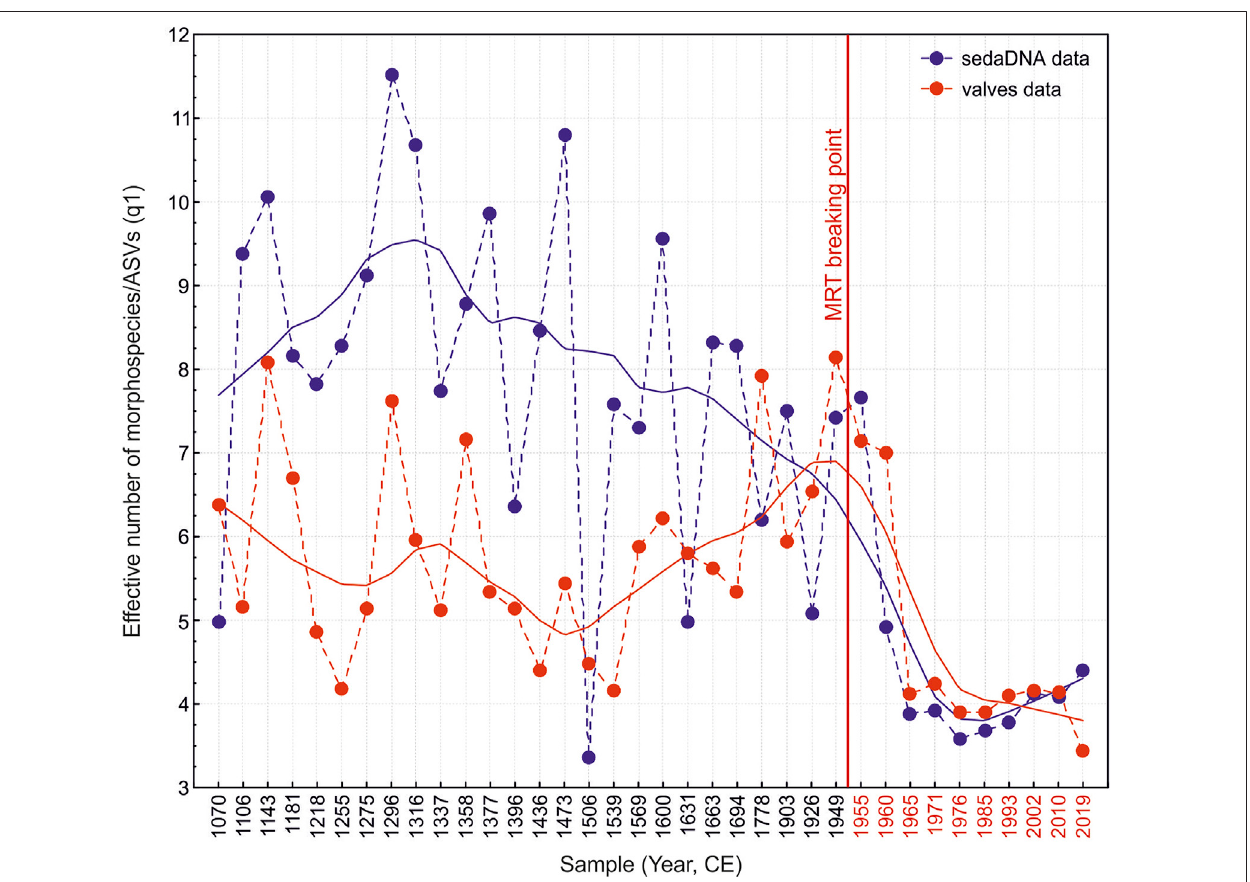
FIGURE 5 | Effective number of morphospecies/ASVs per sample across the sediment core [represented as year (CE), weighted mean age of the core layer ( Supplementary Table S2 )]. The red vertical line denotes the breaking point detected by multivariate regression trees (MRT; for community data). Curves across the data points represent LOWESS fi